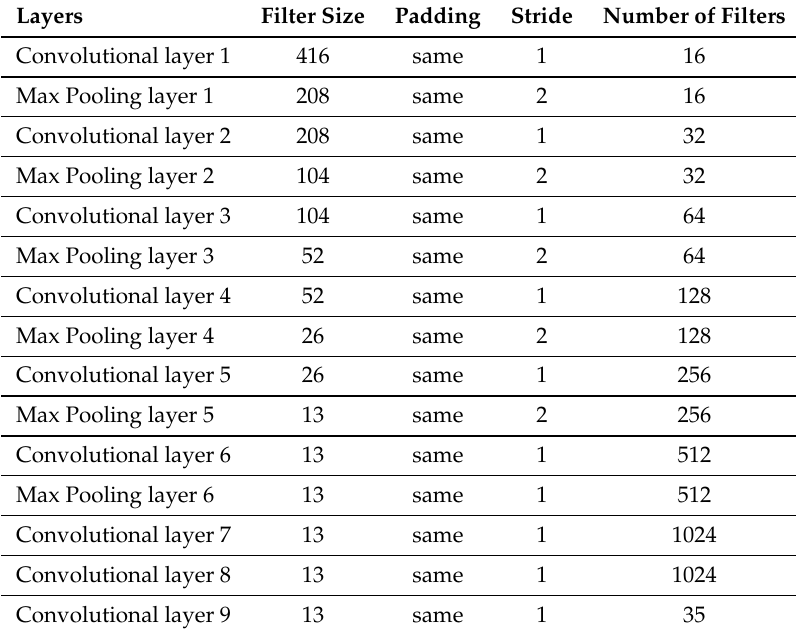
Table 1. Convolutional Neural Network (CNN) layer